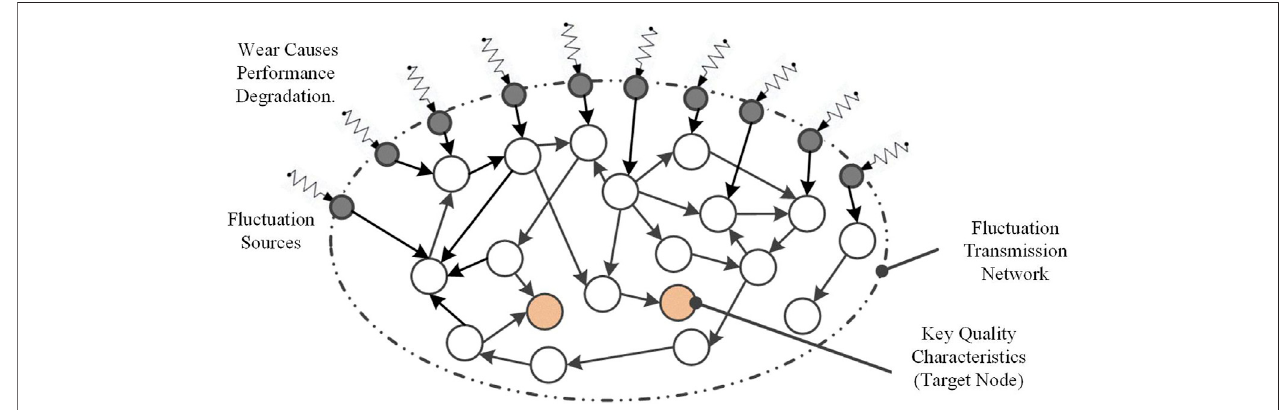
FIGURE 10 | Drive control of fl uctuation